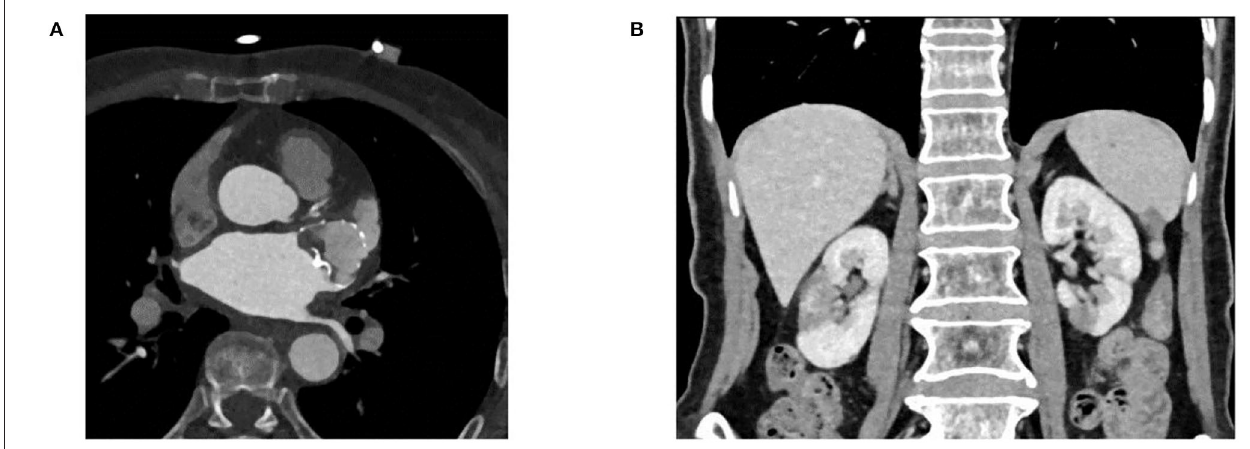
FIGURE 3 | (A) Coronary artery CT angiography showing no protruding device-related thrombus and peri-device leak. (B) Renal artery CT angiography showing no new onset